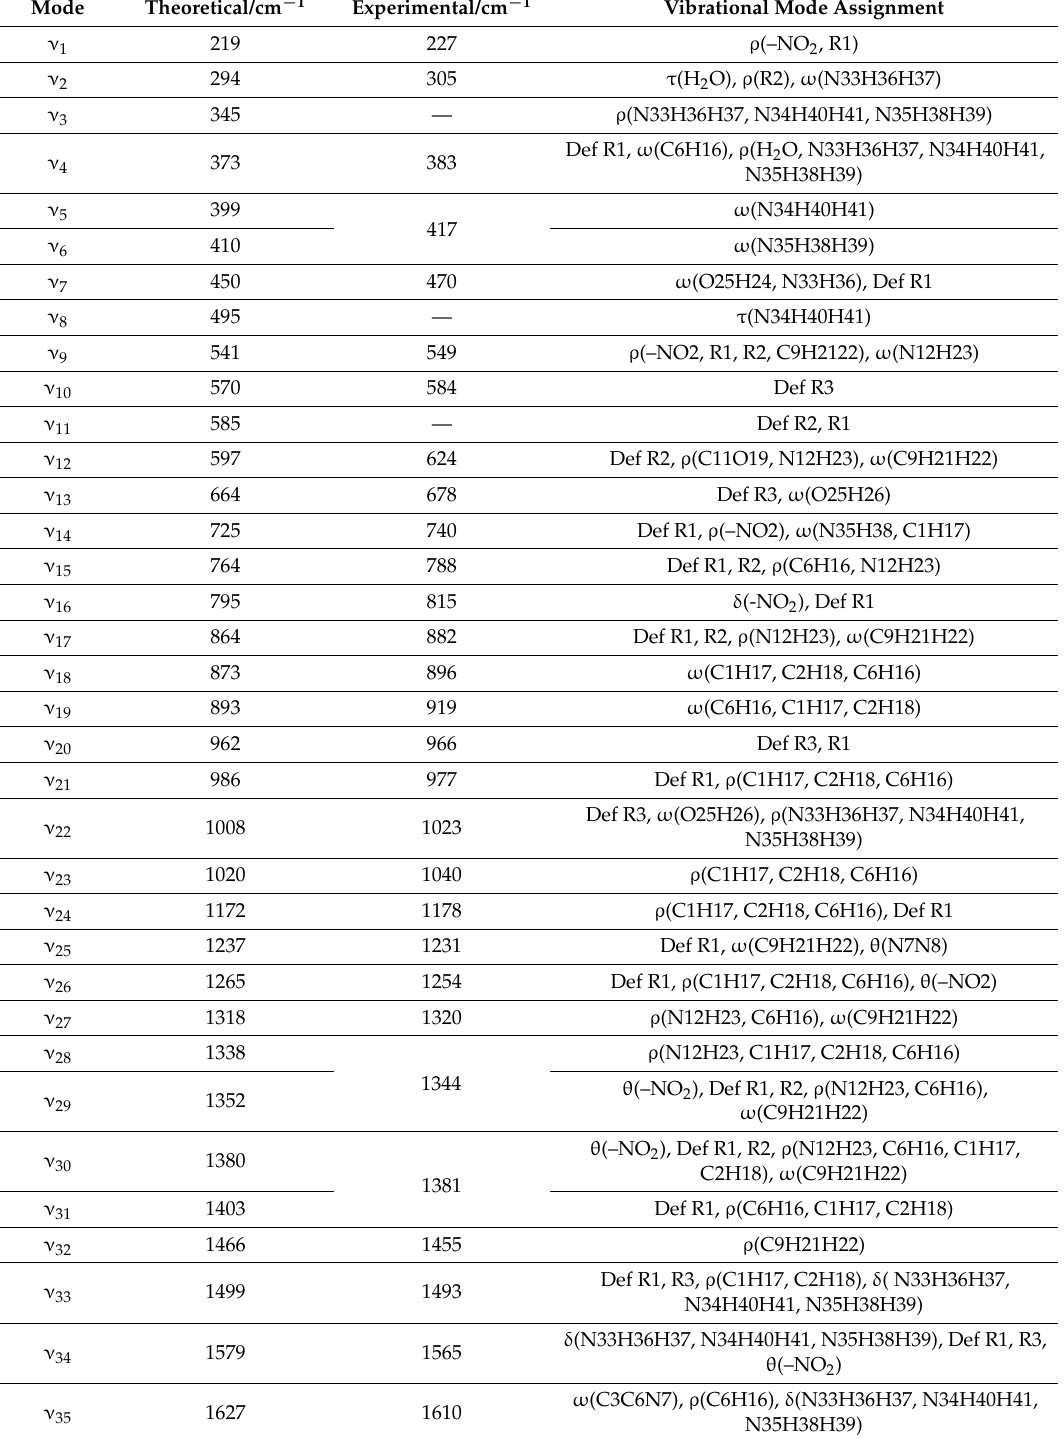
Table 2. Vibrational mode assignment for the Raman characteristic peaks of the NF–MELA-hydrated